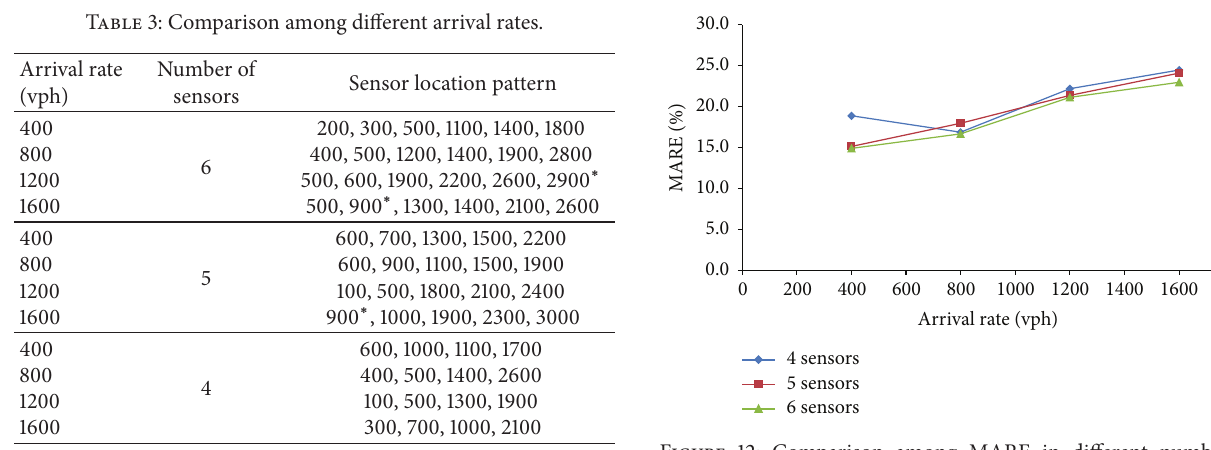
sensor location model (M1) to obtain the minimum travel time estimation error. Based on this model, the influence of traffic signals strategies on sensor location is also